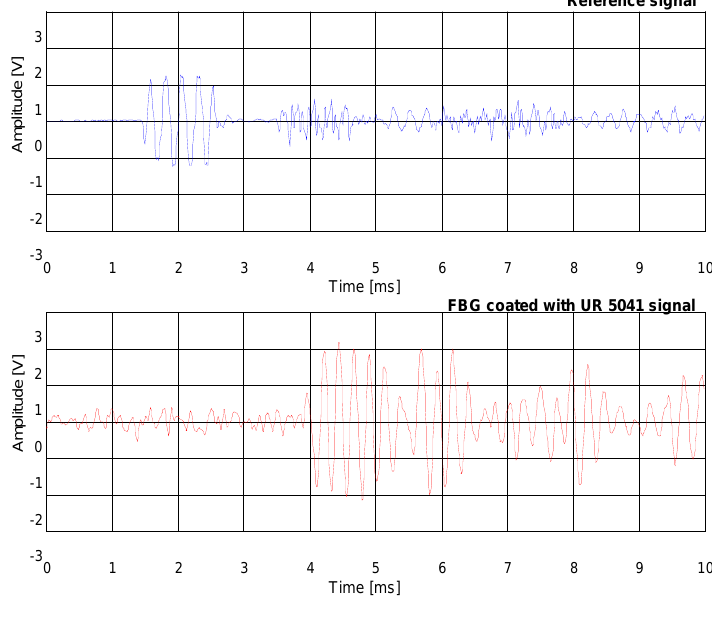
Figure 6 . Temporal response of the reference hydrophone (upper) and the fiber optical hydrophone coated with UR5041 (lower) to a sound pressure pulse at the frequency of 4 kHz and duration of 1 ms.